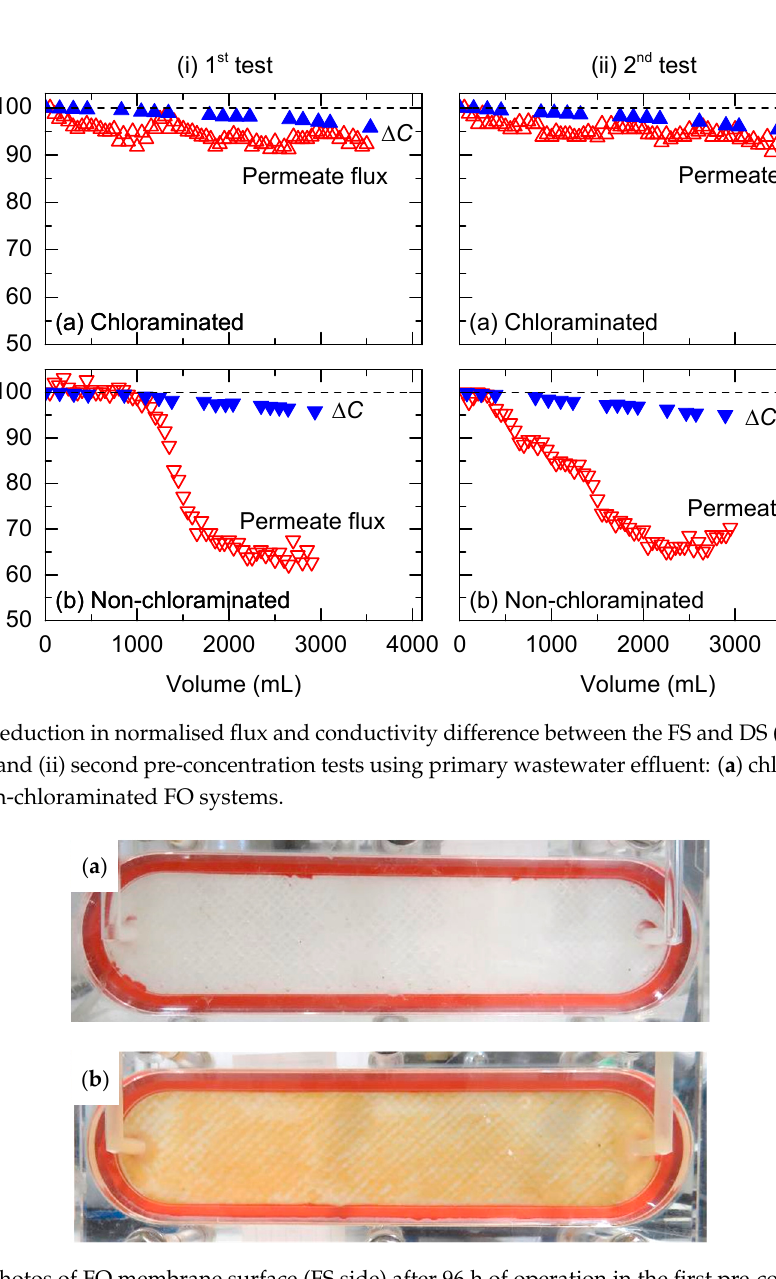
Figure 7. Photos of FO membrane surface (FS side) after 96 h of operation in the first pre-concentration test using primary wastewater effluent: ( a ) chloraminated and ( b ) non-chloraminated.